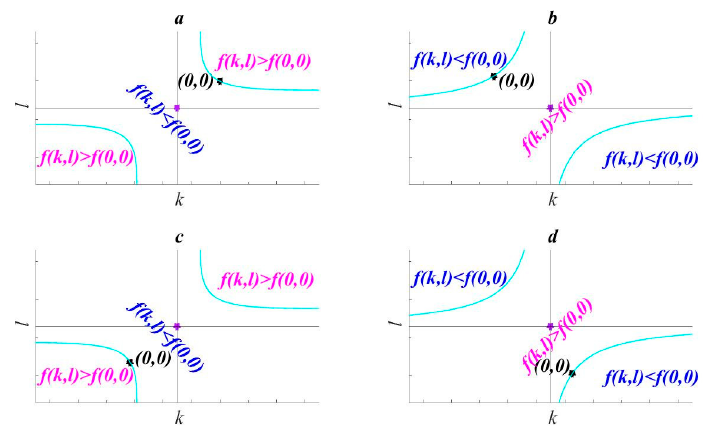
Figure 5. Conceptual map of the spatial distribution of correlation coefficient with trend coefficient. Coordinate origin is to the ( a ) upper-right, ( b ) upper-left, ( c ) lower-left, and ( d ) lower-right of the saddle point.